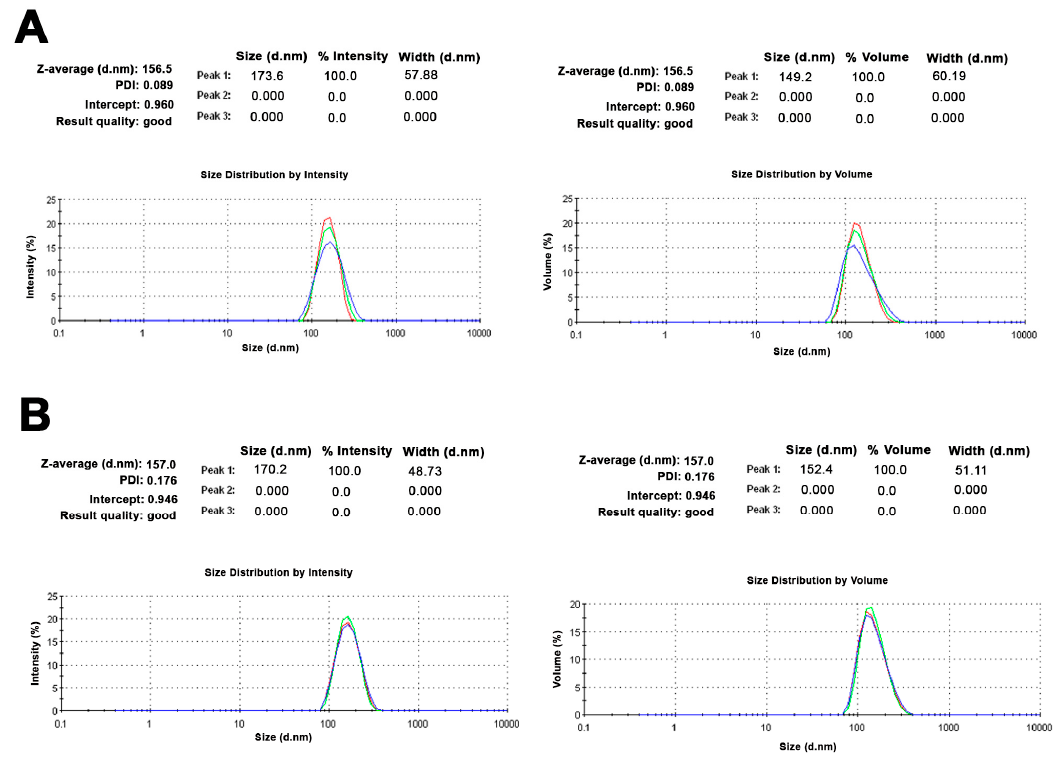
Figure 1. Results of dynamic light scattering (DLS) analysis for transforming growth factor- β 1 (TGF- β 1)-loaded unilamellar vesicles (SUVs) before ( A ) and after the addition of Annexin V ( B ). Mean particle size results for each sample were expressed by signal intensity ( left ) or by volume ( right ).